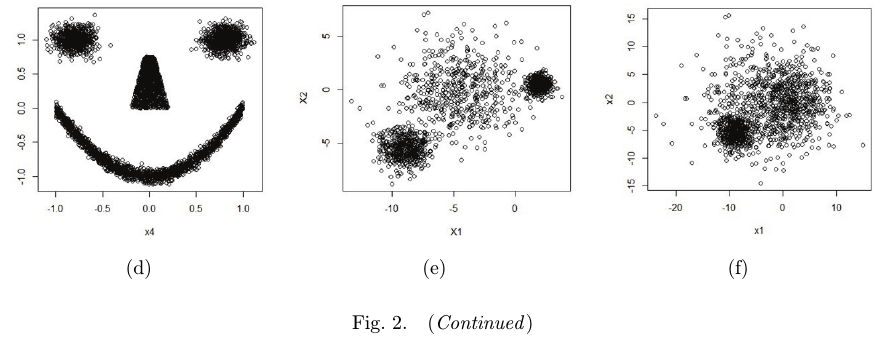
Table 2. k est : Number of clusters estimated, k is known number of clusters in the datasets. Dataset k